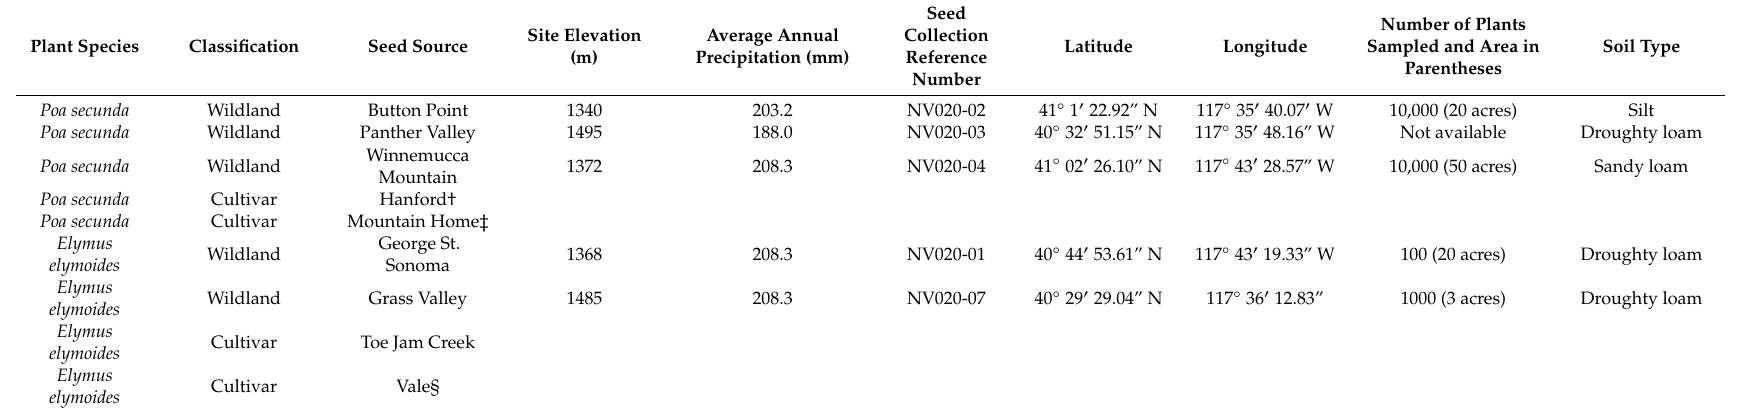
Table 2. Plant species and their classifications used in a greenhouse pot experiment to characterized adult functional traits of native bunchgrasses commonly used in the restoration of the Great Basin shrub steppe ecosystem in the Western United